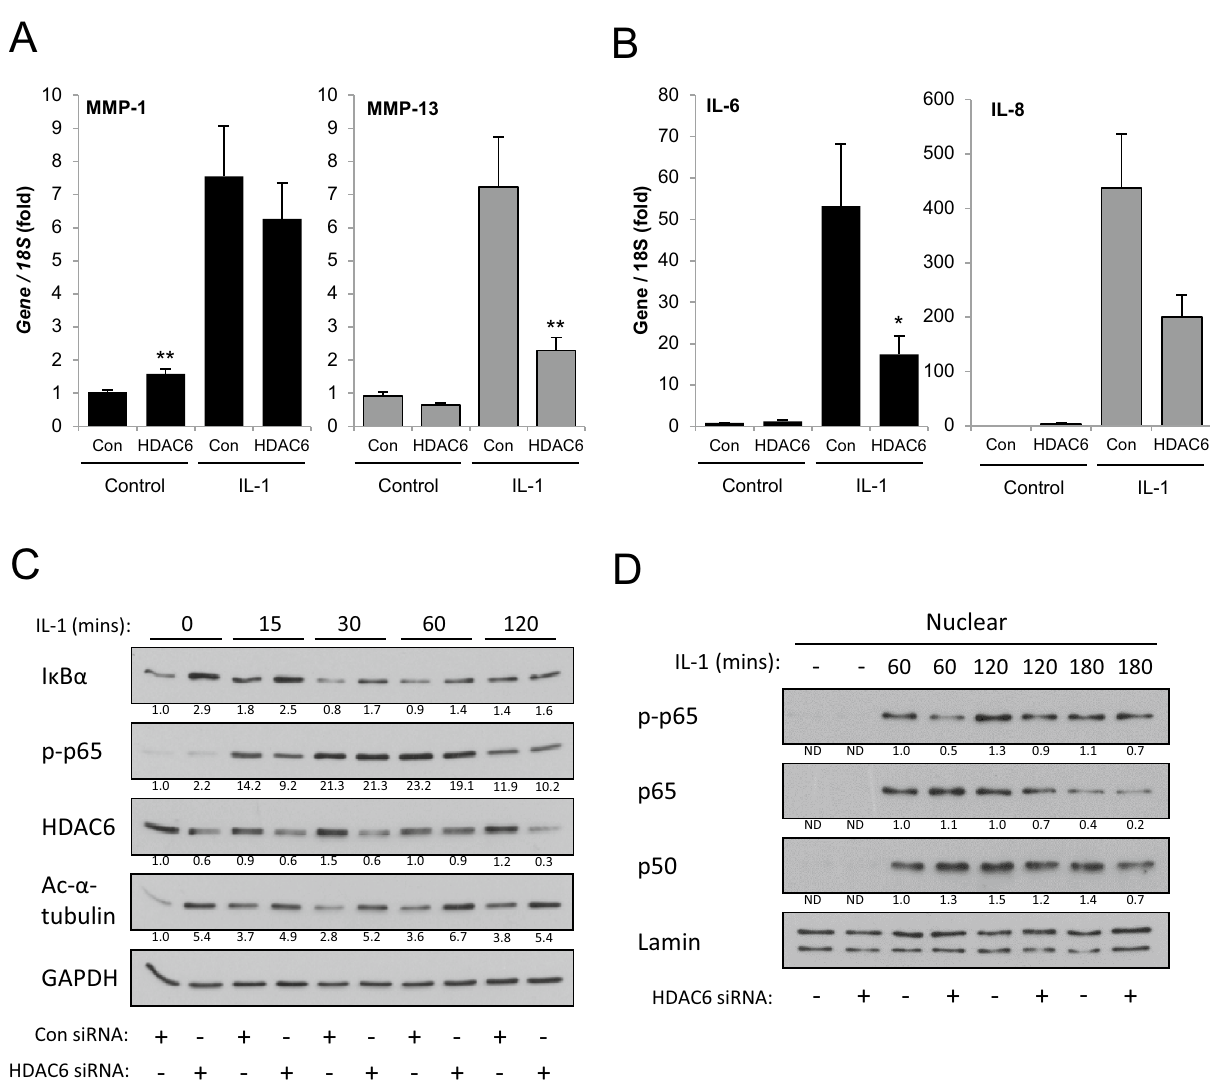
Figure 4. Effect of HDAC6 depletion on MMP gene expression and NF-κB pathway signalling in HAC. ( A – B ) HAC cells were transfected with Dharmacon HDAC6-targetting siRNA for 24 h prior to stimulation with IL-1 for 8 h. RNA was extracted and expression of ( A ) MMP1 and MMP13 , ( B ) IL6 and IL8 measured by real-time RT-PCR. Data are presented as fold induction relative to the basal expression and represent mean of quadruplicate samples ± S.D. (* p < 0.05, ** p < 0.01, *** p < 0.001). Data are representative of a minimum of three independent experiments. ( C–D ) HAC cells were stimulated with IL-1 for the indicated times following transfection with HDAC6-targetting siRNA or control non-targetting siRNA. ( C ) Total protein was extracted and the activation or abundance of the indicated NF-κB pathway proteins detected by immunoblotting. HDAC6 levels were measured to confirm knockdown and GAPDH was used to confirm equal protein loading. ( D ) Nuclear protein was extracted and the level of the indicated NF-κB pathway proteins detected by immunoblotting. Nuclear Lamin was used to confirm equal protein loading. ( C – D ). Densitometric quantification data are shown below each blot as fold change in relation to the first detectable sample, normalised to ( C ) GAPDH or ( D ) Lamin. Data are representative of a minimum of three independent